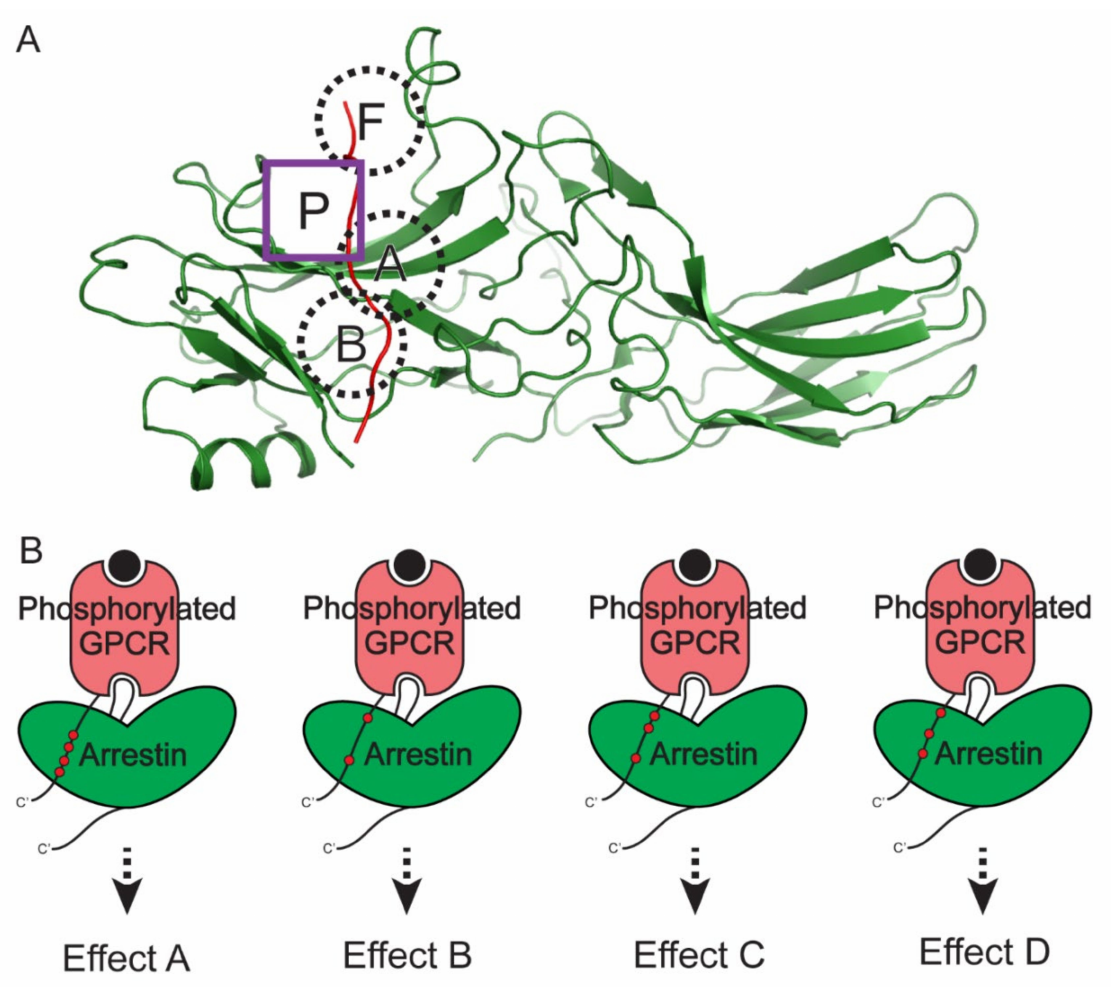
Figure 4. Distinct downstream signaling effects that are mediated by different phosphorylation patterns of GPCRs. ( A ) The four known phosphate-binding pockets on arrestins. The structure of CXCR7 phosphopeptide (red) and the activated β -arrestin 2 (green) complex (PDB: 6K3F) is shown as a representative structure. The conserved positively charged pockets on arrestins (pocket A, B, and F) are shown in the dashed black circles. The newly identified phosphate-binding pocket P on β -arrestin 2 is shown in the purple square. ( B ) Differently phosphorylated GPCRs induce differently activated β -arrestins, leading to distinct downstream signaling